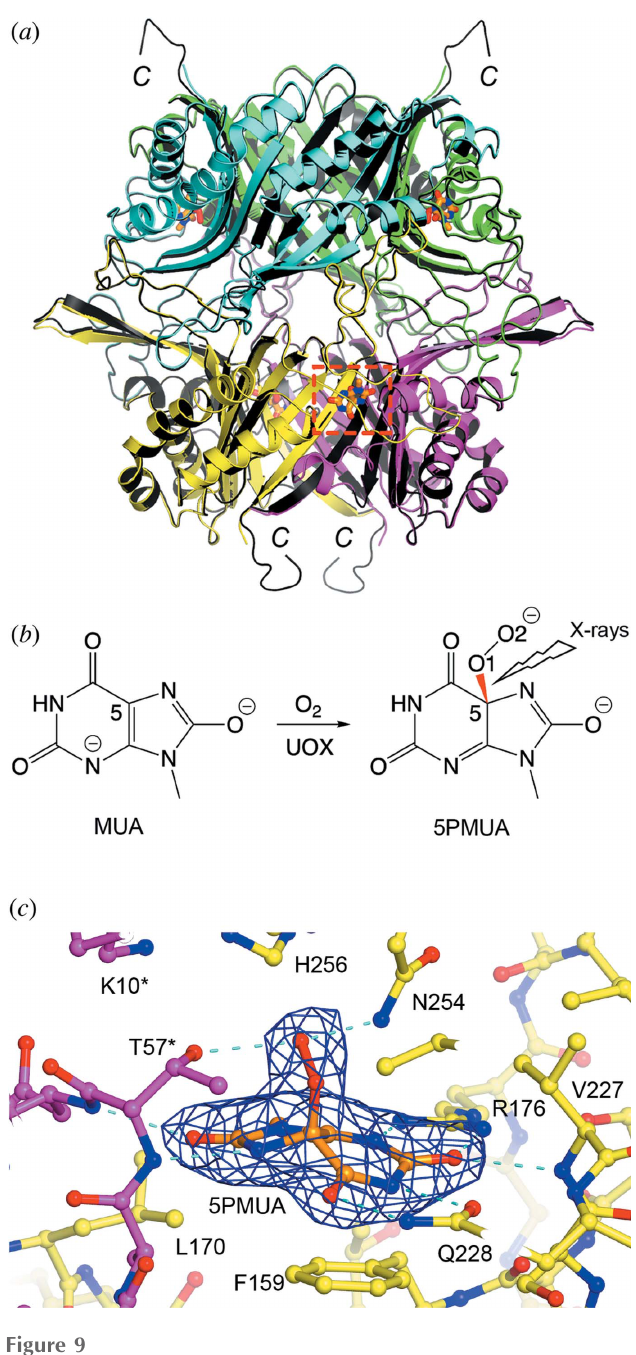
Figure 9 ( a ) Comparison of the UOX-5PMUA complex at RTand 100 K. The four UOX protomers from the RT structure are shown in yellow, magenta, green and cyan while the whole UOX tetramer (PDB code 4cw2) solved at 100 K is shown in black. The four 5PMUA molecules that bind at the interface between two protomers are shown as sticks; one is highlighted by a dashed red box for clarity. The flexible C-terminus (indicated by the letter C) is not observed in the present RT structure. ( b ) Scheme of the reaction that converts UOX-bound MUA into its 5PMUA derivative under aerobic conditions. The C5—O1 bond that is very susceptible to X-ray-induced rupture is shown in red. ( c ) Active site of the UOX- 5PMUA complex from SSX data at 2.3 A˚ resolution. UOX residues at the interface are shown in stick representation and are color-coded according to the subunit they belong to. 2 mF o (cid:2) DF c electron density contoured at the 1 (cid:5) level is shown in blue for 5PMUA. Hydrogen bonds involving 5PMUA are shown as cyan dashed